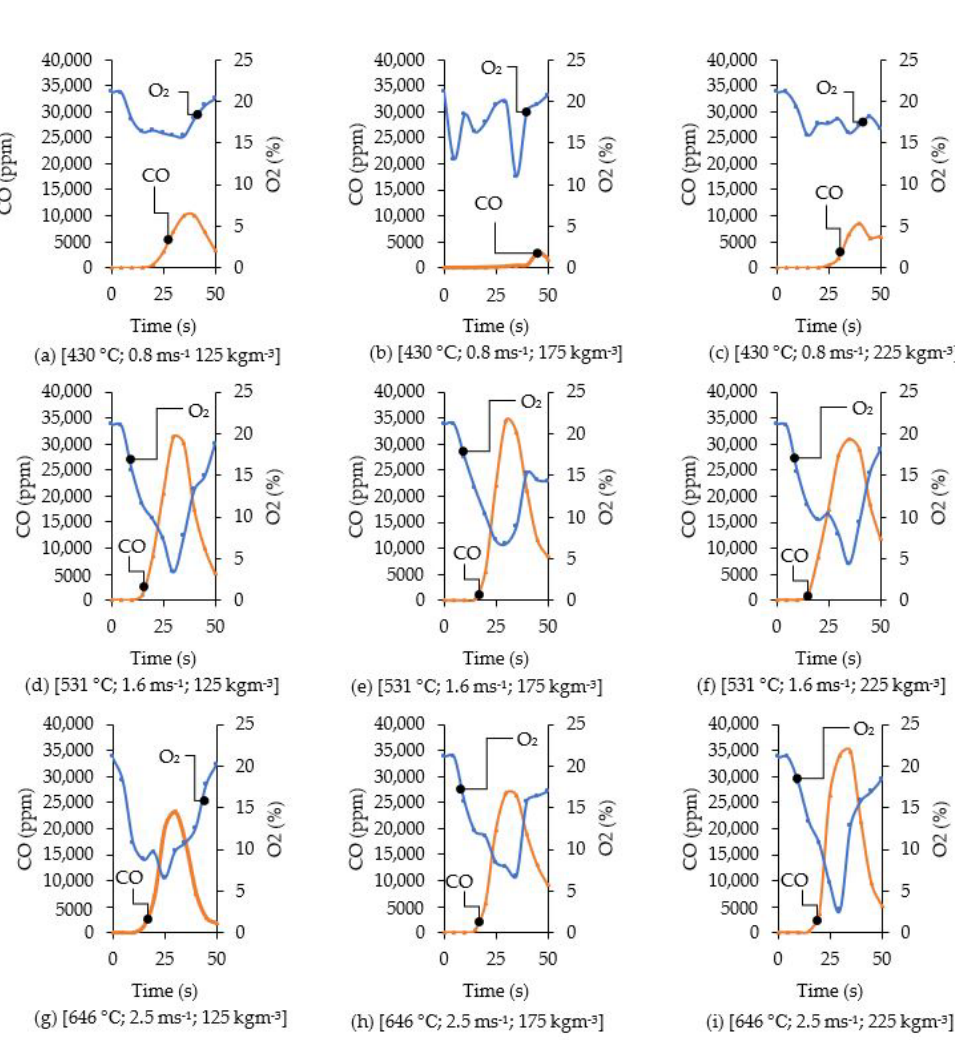
Energies 2023 , 16 , x FOR PEER REVIEW Figure 8. CO (ppm) and O 2 (%) emission trend from the 30 s combustion duration of rice husk after the hot air preparation stage [Temperature; Air flow rate; Sample density].